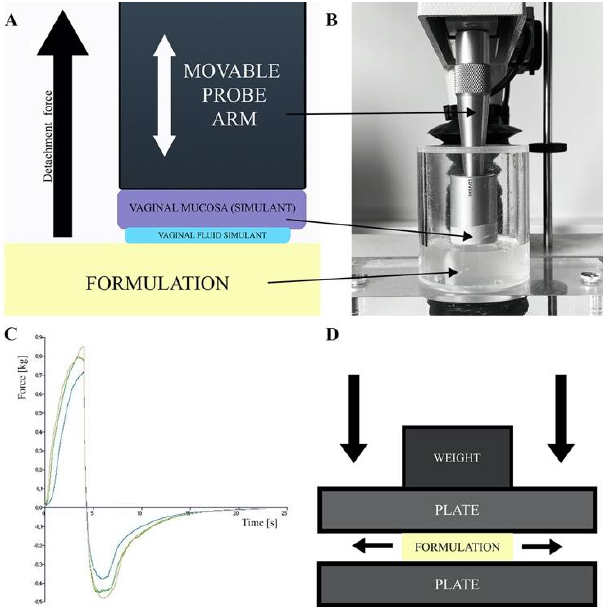
Figure 4. ( A ) Scheme of adhesion measurements by detachment method, ( B ) texture analyzer stable micro system, ( C ) adhesion measurement sample result and ( D ) spreadability test by plate-plate